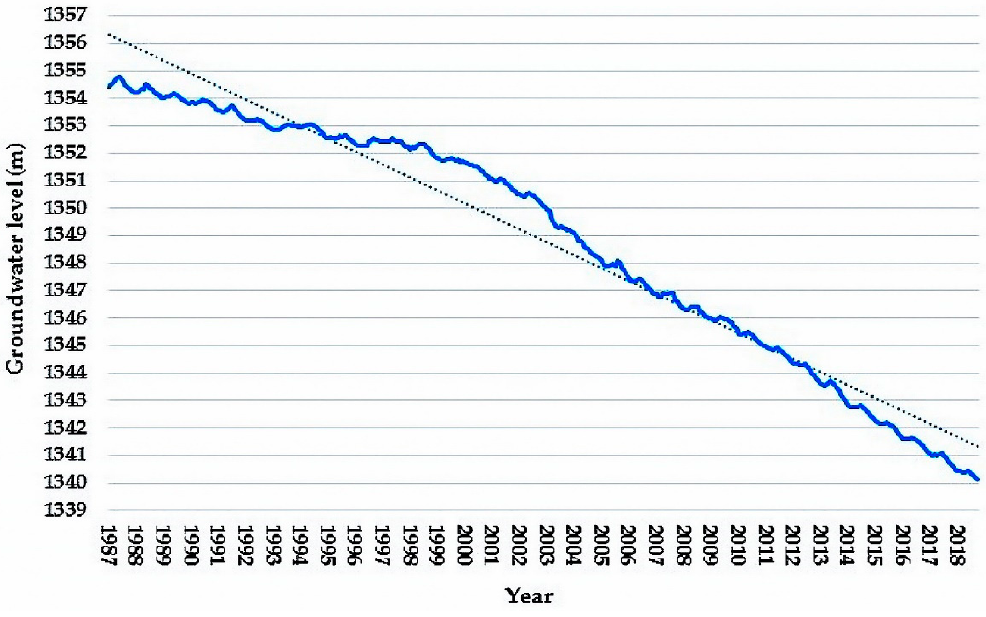
Figure 4. Groundwater hydrograph of Birjand Plain during a 30-year period.